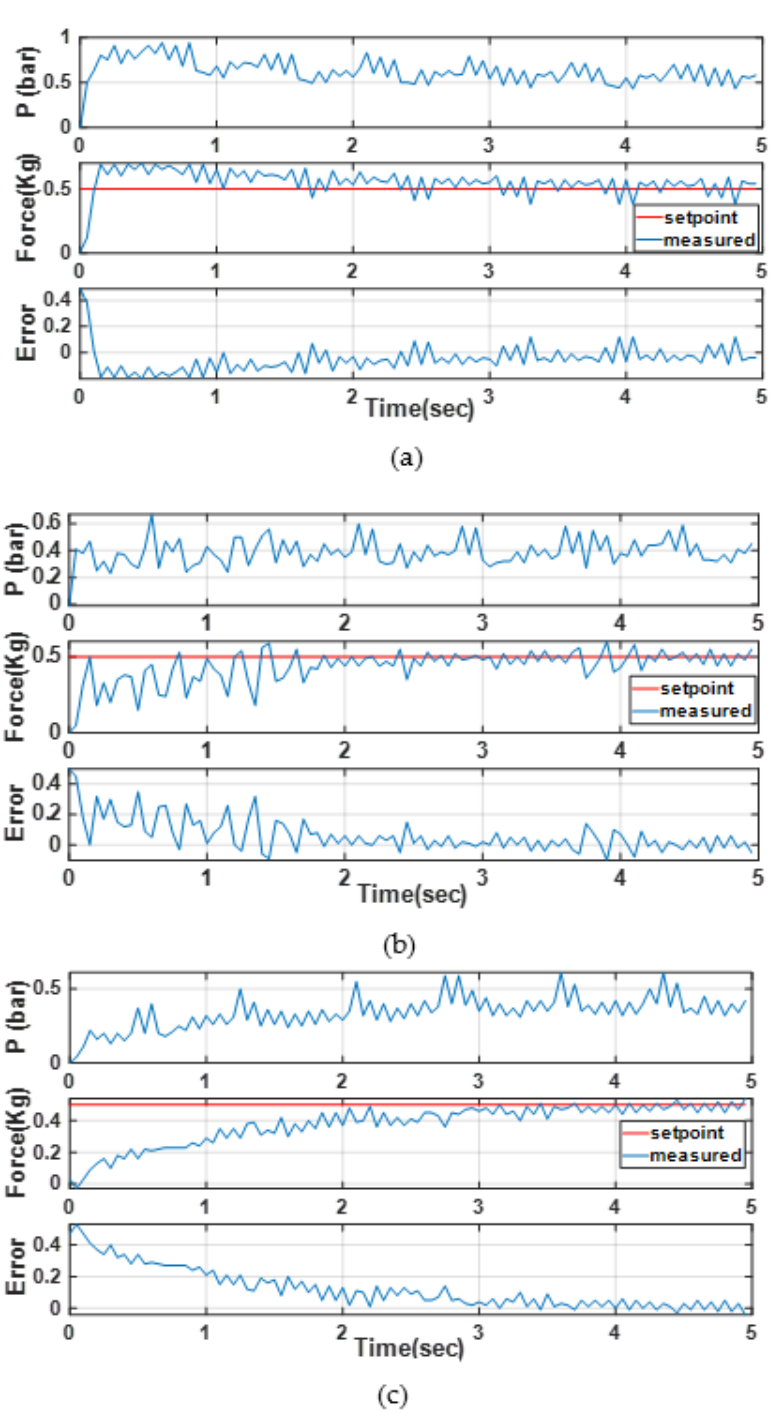
Figure 13. Experimental results of the change of pressure, force, and error with time by using: ( a ) Z.N tuning technique; ( b ) GA tuning technique; ( c ) PSO tuning technique.